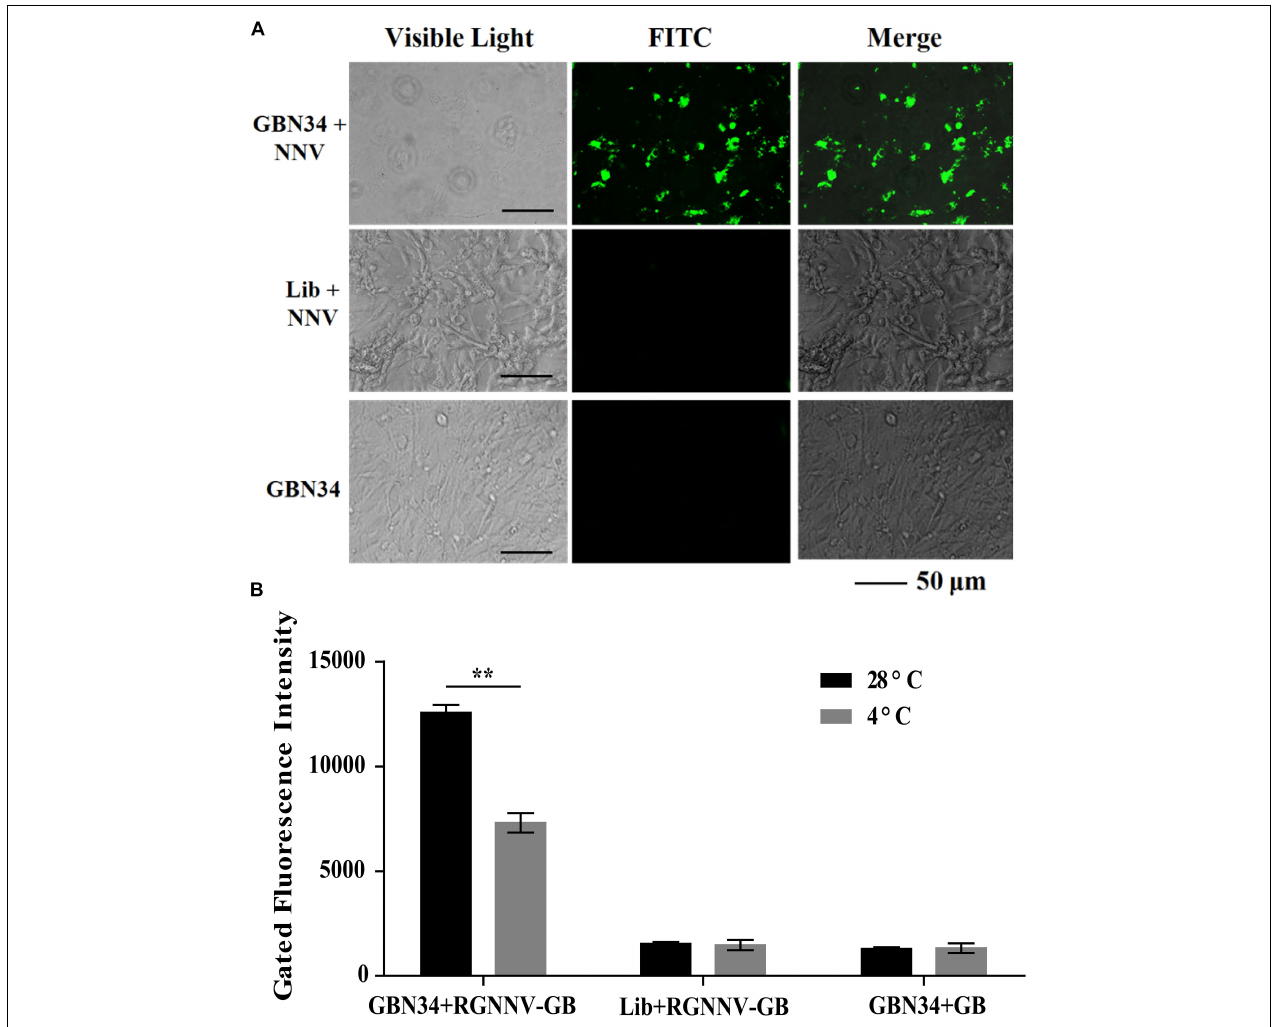
FIGURE 6 | Cell-specific internalization of aptamer GBN34. (A) Fluorescent images of FITC-labeled GBN34 after incubation with RGNNV-infected cells for 2 h at 28 ◦ C. Scale bars indicate 50 µ m. (B) Internalization analysis of GBN34. Fluorescence values of FAM-labeled GBN34 incubated with RGNNV-infected cells at 28 ◦ C were much more than at 4 ◦ C, with the specific active internalization of aptamer GBN34 into RGNNV-infected